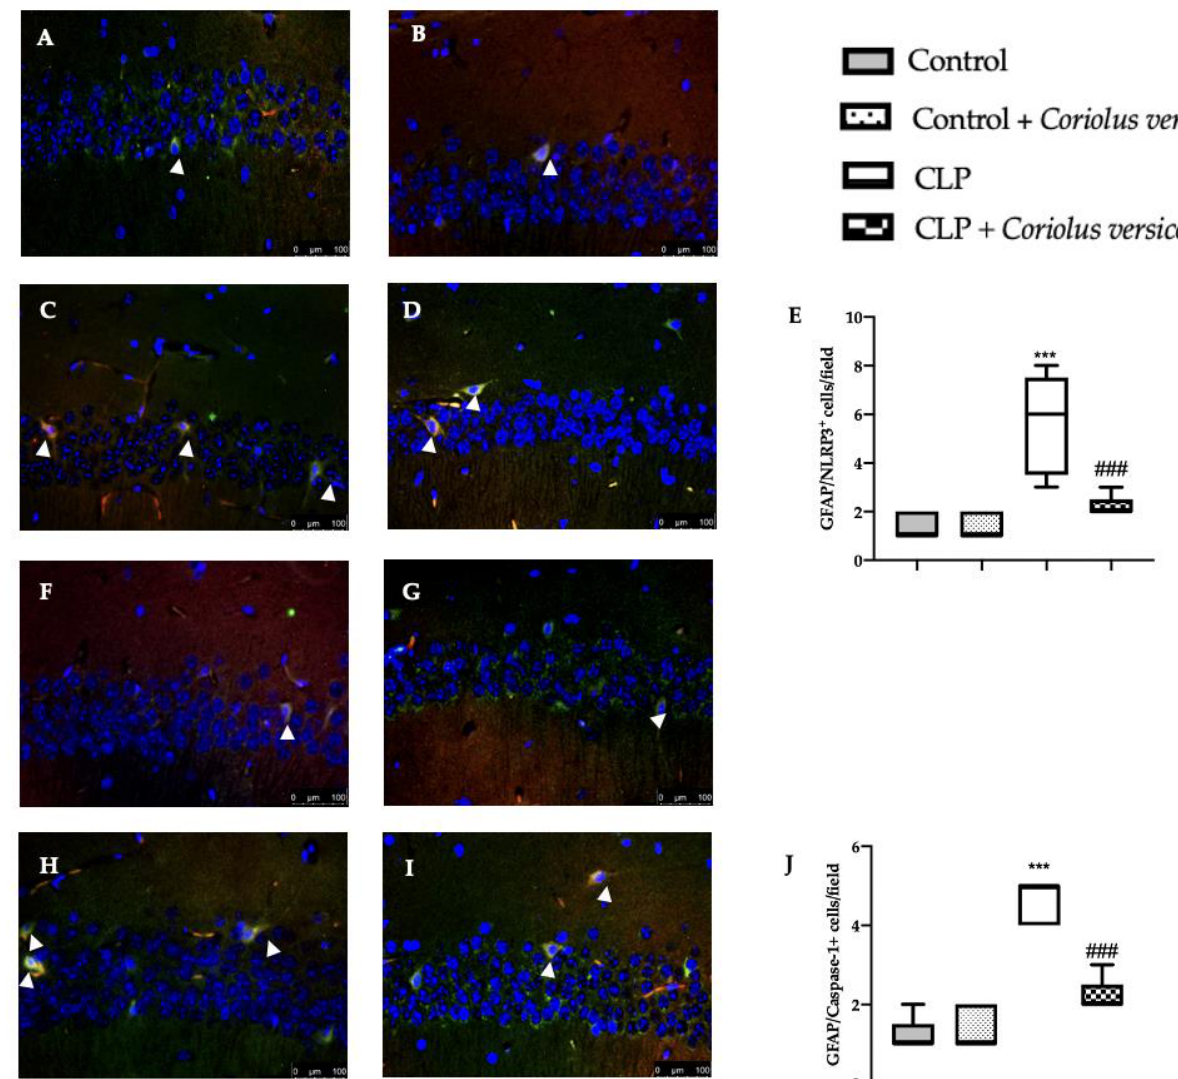
Figure 10. Coriolus versicolor reduced glial fibrillary acidic protein (GFAP)/NLR family pyrin domain containing 3 (NLRP3) and GFAP/Caspase-1 colocalization induced by CLP 28 days after surgery. Immunofluorescence analysis of GFAP/NLRP3: Control ( A ), Control + Coriolus versicolor ( B ), CLP ( C ), CLP + Coriolus versicolor ( D ), graphical quantification of GFAP/NLRP3 colocalization ( E ), im- munofluorescence analysis of NLRP3/Caspase-1: Control ( F ), Control + Coriolus versicolor ( G ), CLP ( H ), CLP + Coriolus versicolor ( I ), graphical quantification of NLRP3/Caspase-1 colocalization ( J ). *** p < 0.001 vs. control, ### p < 0.001 vs. CLP.